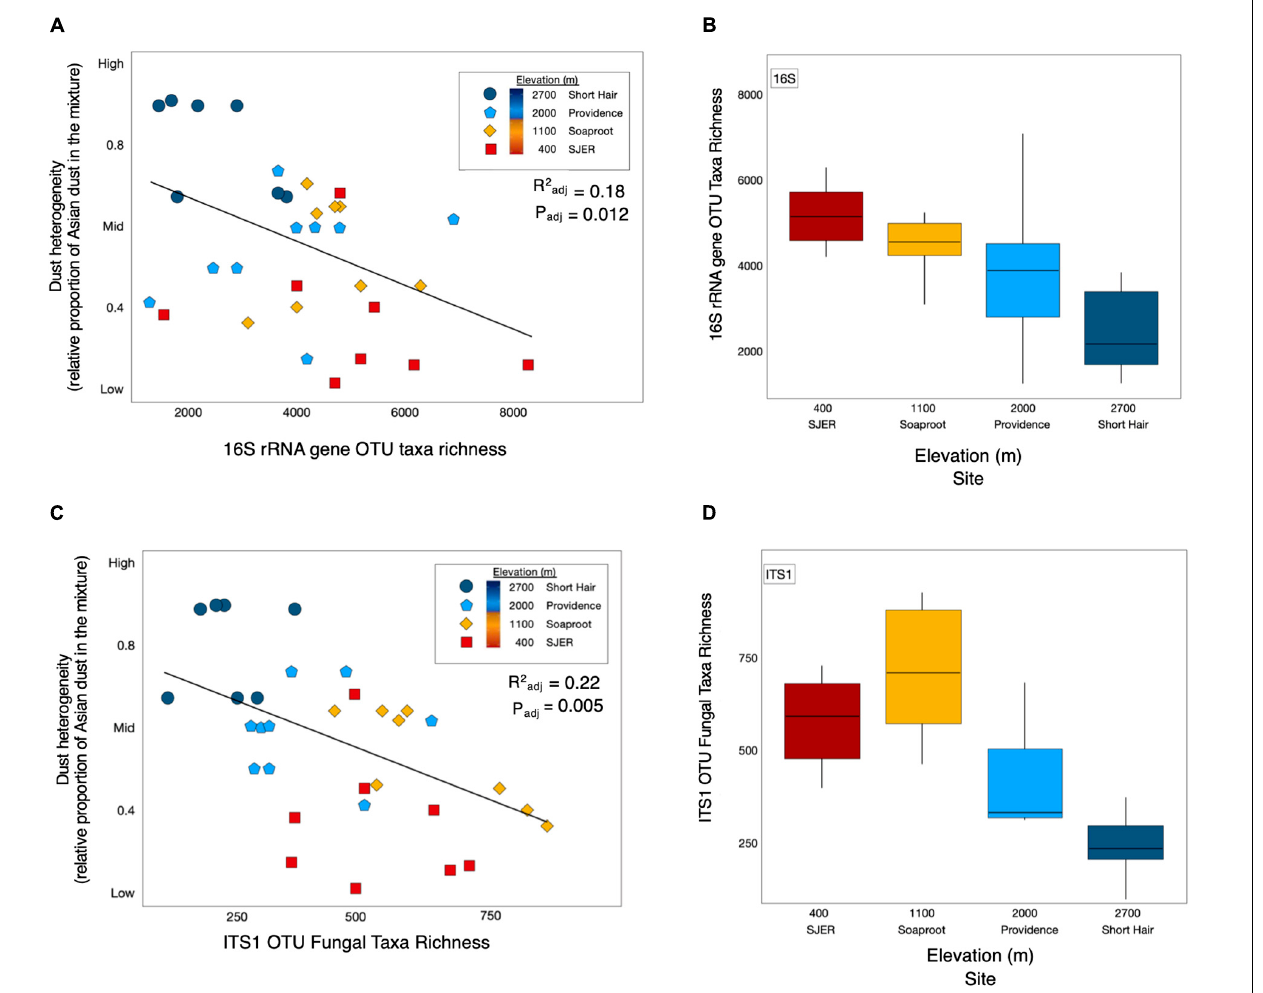
FIGURE 2 | Dust heterogeneity varies by elevation and 16S rRNA gene OTU bacterial and fungal ITS1 microbial taxa richness. Dust complexity and 16S rRNA gene OTU microbial taxa richness varied by site along the elevation gradient. Linear regression of bacterial and archaeal taxa richness from 16S rRNA marker gene targeted amplicon sequencing shows that microbial taxa richness corresponded with dust heterogeneity and elevation (A) . Microbial taxa richness varies by site along the elevation gradient (B) . ITS1 fungal OTU taxa richness (C) was correlated with dust heterogeneity (C) and elevation (D) across sites in the